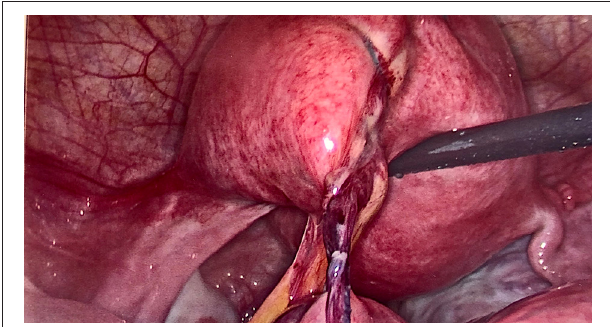
FIGURE 1 | A tail of the absorbable barbed suture entangled in an ileal